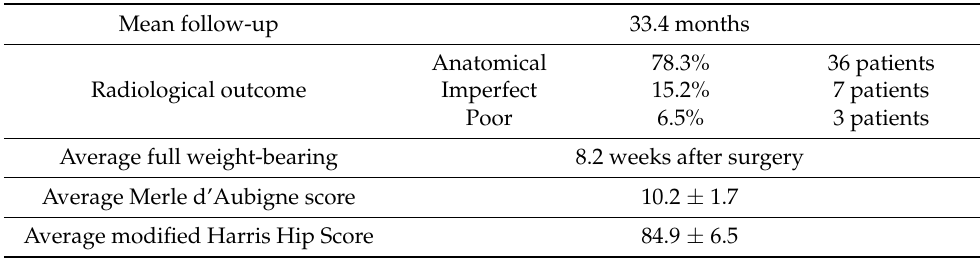
Table 2. Clinical and radiological data after